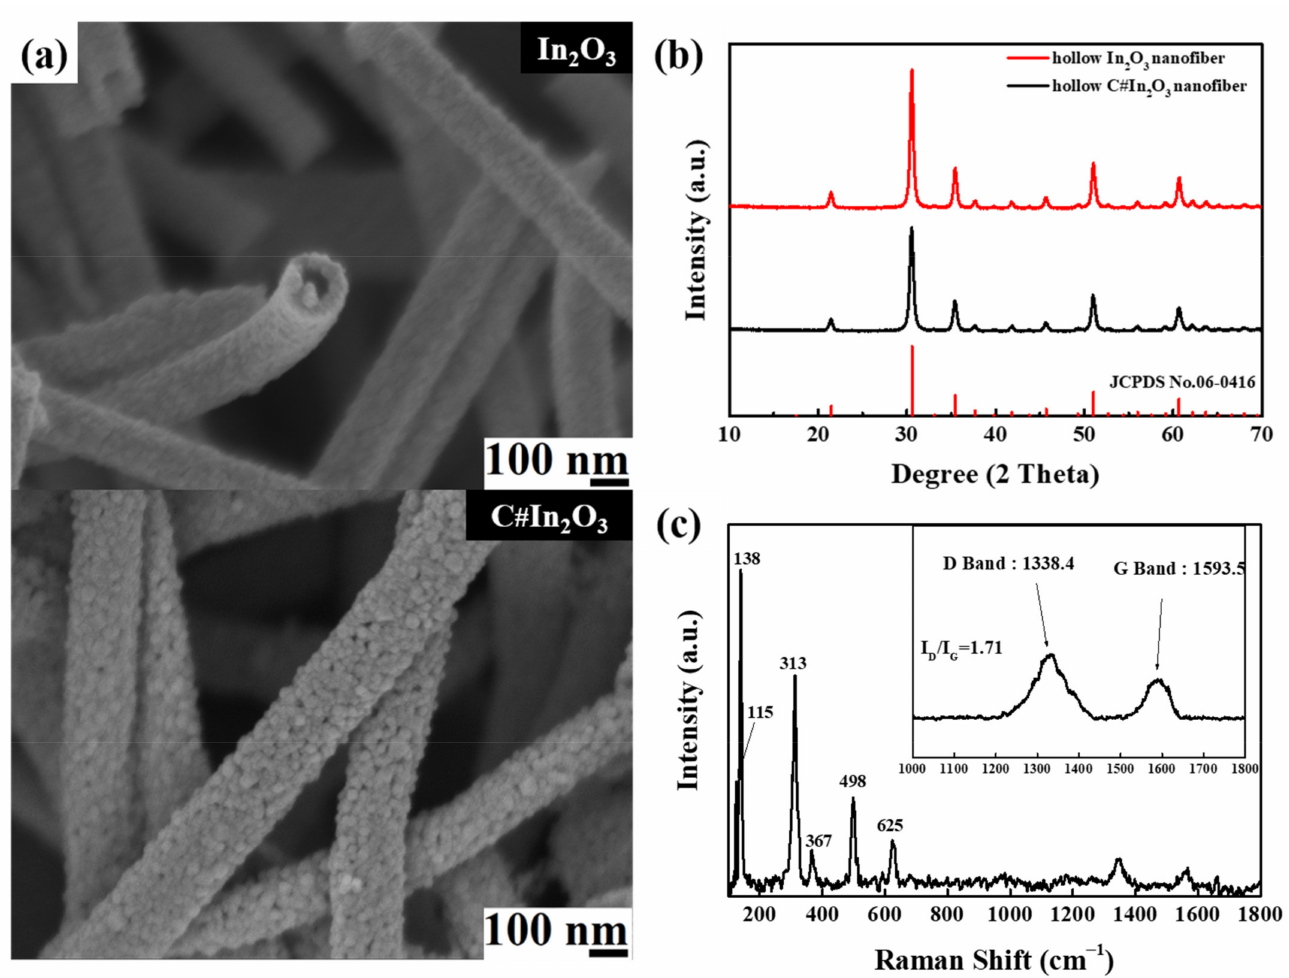
Figure 1. ( a ) SEM images of hollow In 2 O 3 and C#In 2 O 3 nanofibers, ( b ) WAXD data of hollow In 2 O 3 and C#In 2 O 3 nanofibers, and ( c ) Raman spectra of hollow and C#In 2 O 3